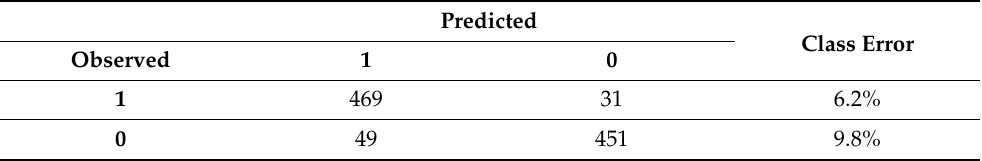
Figure 7. Processed high-resolution aeromagnetic layer for the Moolart Well area overlain by the predicted results via SRF classifier. The blue colour represents the areas predicted as the positive class, whereas the red colour represents the areas predicted as the negative class. The yellow marker shows the point location of the main deposit, with a yellow outline the approximate envelope of the mineralised ferricrete unit. Table 5. Confusion matrix for the SRF classifier—Moolart Well area.